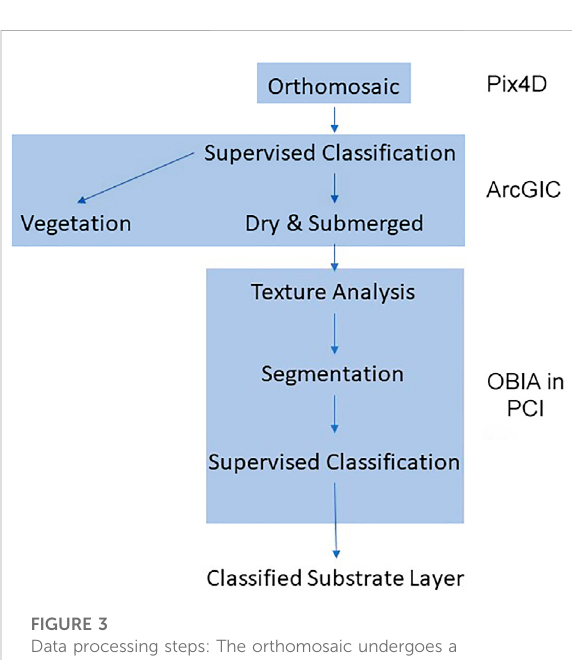
FIGURE 3 Data processing steps: The orthomosaic undergoes a supervised classi fi cation (ArcGIS) to separate the RV from the substrate. The substrate is then analyzed for texture. The pixel values of the substrate are used to segment the image into substrate sizes, which are assigned through another supervised classi fi cation in